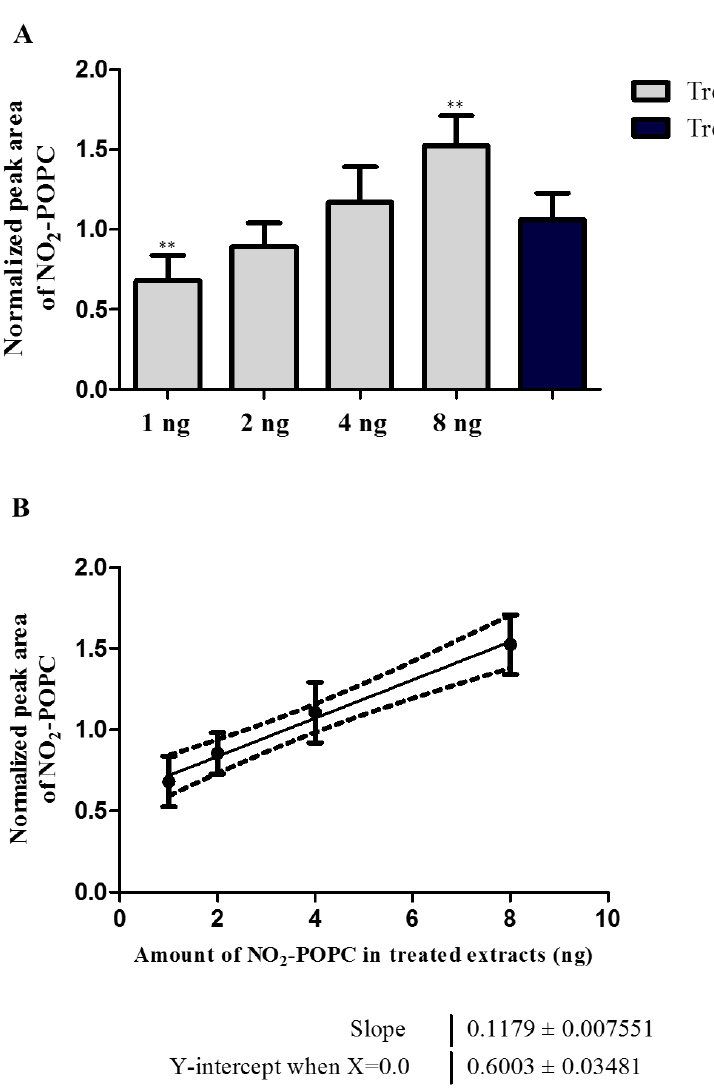
Figure 4. ( A ) NO 2 -POPC at m / z 805 detected using hydrophilic interaction liquid chromatography (HILIC)- mass spectrometry (MS) and MS / MS analysis in green fluorescent protein (GFP)-vimentin SW13 / cl.2 cells treated with 1 µ L (1 ng), 2 µ L (2 ng), 4 µ L (4 ng) and 8 µ L (8 ng) of nitrated POPC (1 µ g mL − 1 ) and the lipid extracts of SW13 / cl.2 cells treated with nitrated POPC (10 µ mol L − 1 ). The results were expressed as peak areas, normalized by the ratio between the peak area of NO 2 -POPC and of the PC internal standard (dMPC, PC 14:0 / 14:0). The values are the means of six experiments (three biological replicas acquired in duplicate) ± standard deviation (SD). Statistical significance was determined using ANOVA and Tukey’s multiple comparison tests (** p < 0.01). ( B ) Linear regression analysis used to estimate the amount of NO 2 -POPC in the lipid extracts from the cells treated with nitrated POPC (10 µ mol L − 1 ) based on the relationship between the normalized peak area and the amount of NO 2 -POPC in the lipid extracts treated with 1 µ L (1 ng), 2 µ L (2 ng), 4 µ L (4 ng) and 8 µ L (8 ng) of nitrated POPC (1 µ g mL − 1 ).